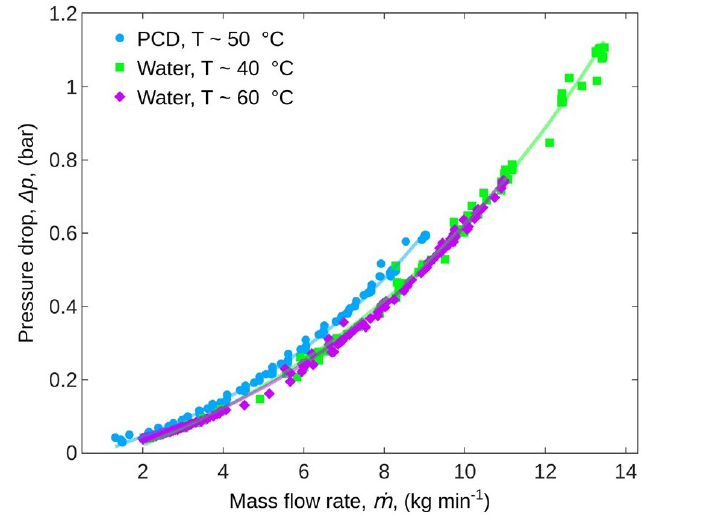
Figure 8. The pressure drop versus mass flow rate for the investigated PCD at 50 ◦ C, and for water at 40 and 60 ◦